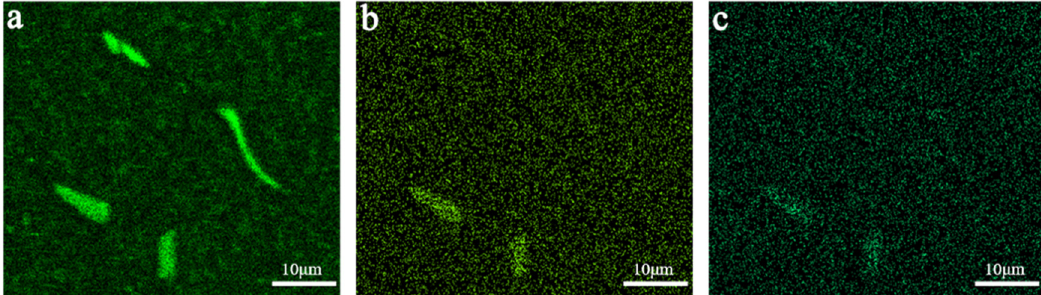
Figure 5. Elemental mapping of the alloy homogenized at 500 °C for 20 h: ( a ) Cu (Cu-rich precipitate arrowed by N), ( b ) Ce, and ( c ) La elements.